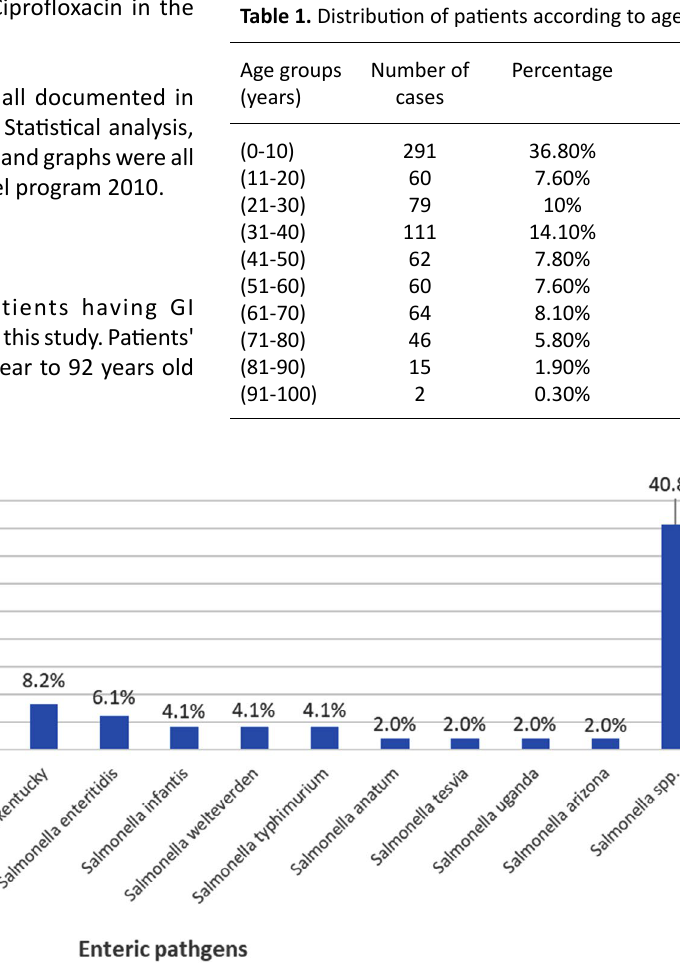
(Table 1). Of 790 patients, 414 were females & 376 were males (Table 2).